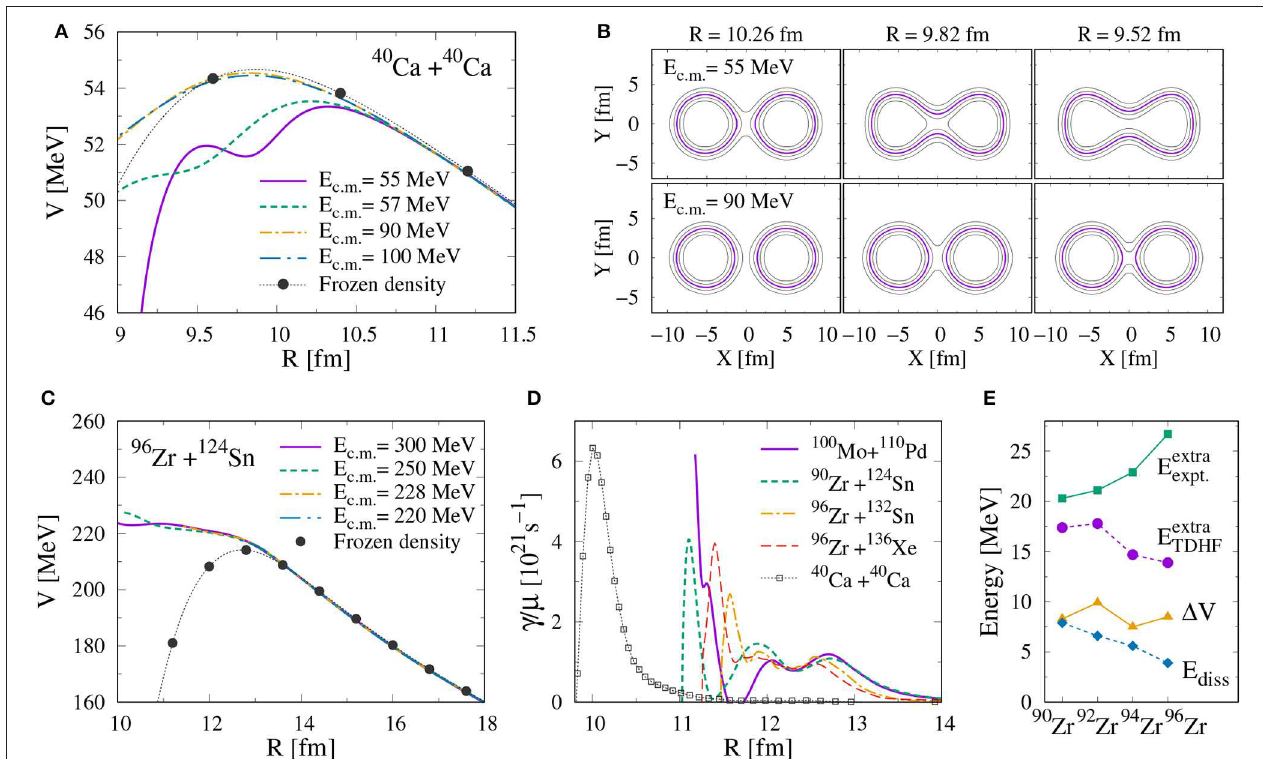
FIGURE 1 | (A) Nucleus–nucleus potentials denoted by lines obtained by DD-TDHF at different energies and by the frozen-density approximation by filled circles with the dotted line as a function of R in 40 Ca + 40 Ca. (B) Contour plots of density profile ρ ( X , Y ,0) obtained from TDHF at E c.m. = 55MeV (upper panels) and at E c.m. = 90MeV (lower panels), at R = 10.26fm (left panels), 9.82fm (middle), and 9.52fm (right) in 40 Ca + 40 Ca. The isodensities (contour lines) are plotted at each 0.025fm − 3 . (C) Same as (A) but for 96 Zr + 124 Sn. (D) Friction coefficient divided by reduced mass, γ/µ , from DD-TDHF. (E) Extra-push energy from experiments ( E extra expt. ) and from TDHF ( E extra TDHF ) together with potential increase 1 V and dissipated energy E diss for 90,92,94,96 Zr + 124 Sn (see text for detail). (A,B) adopted from Washiyama and Lacroix [19], (C,D) adopted from Washiyama [41], and (E) adopted from Washiyama [41] with slight change with permission from APS and SciPris.